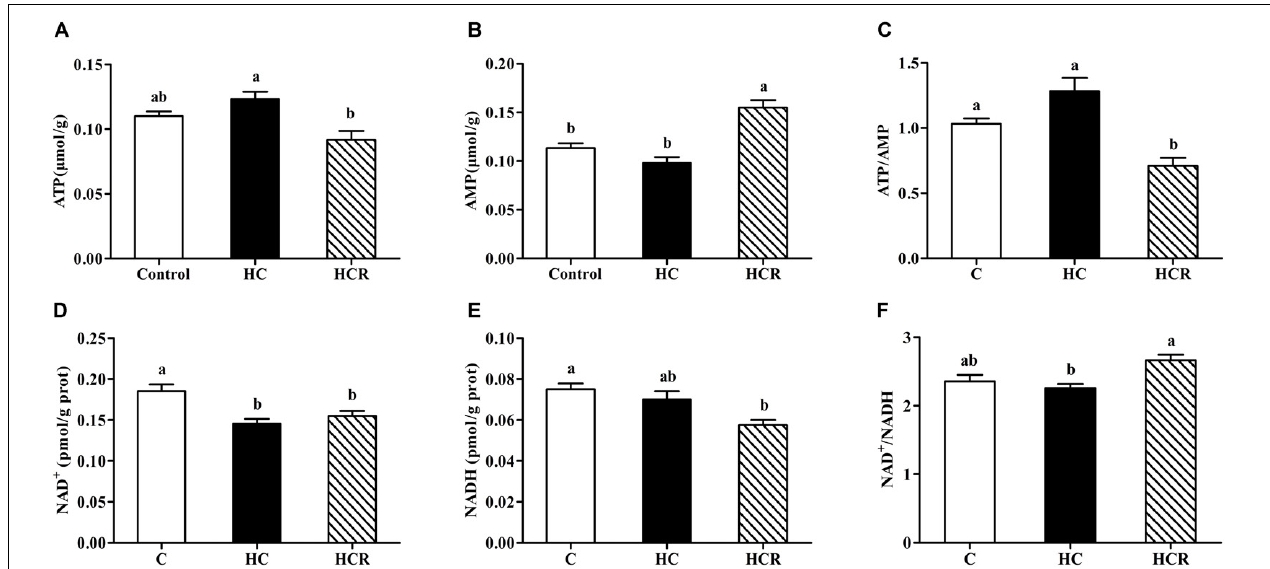
FIGURE 1 | Liver ATP contents (A) , AMP contents (B) , the ATP/AMP ratio (C) , NAD + contents (D) , NADH (E) contents and the NAD + /NADH ratio (F) of blunt snout bream fed different experimental diets. Each data represents the mean of four replicates. Bars assigned with different letters are significantly different ( P < 0.05). Control, diet with 30% carbohydrate level; HC, diet with 41% carbohydrate level; HCR, diet with 41% carbohydrate and 0.04% resveratrol. ATP, adenosine triphosphate; AMP, adenosine monophosphate; NAD + , nicotinamide adenine dinucleotide; NADH, nicotinamide adenine dinucleotide phosphate.